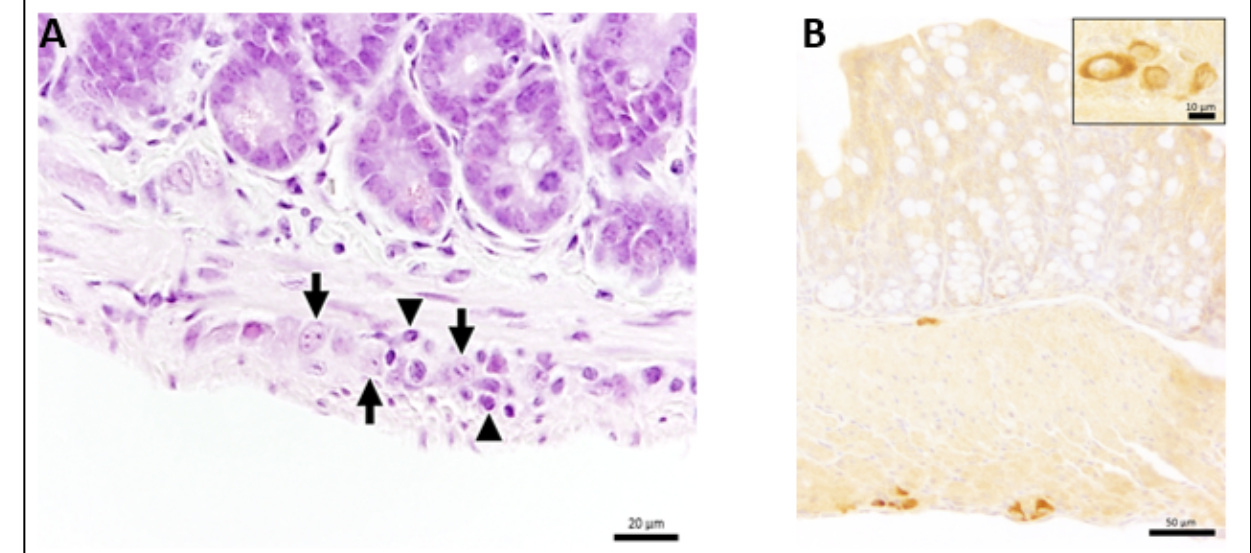
Figure 2. ( A ) H&E staining showing ganglioneuritis of the myenteric plexus of M21 at 11 dpi. Neurons of the ganglion (arrows) are surrounded by inflammatory cells (arrowheads). ( B ) Staining for TBEV antigen in the large intestine of M18 at 9 dpi. TBEV antigen is present in the myenteric and submucosal plexus of the large intestine. The insert shows the intracytoplasmic localization of viral antigen. Staining 1:800 with anti-TBEV-rabbit serum. Bars represent 20 µm ( A ) and 50 µm as well as 10 µm for the insert ( B ).